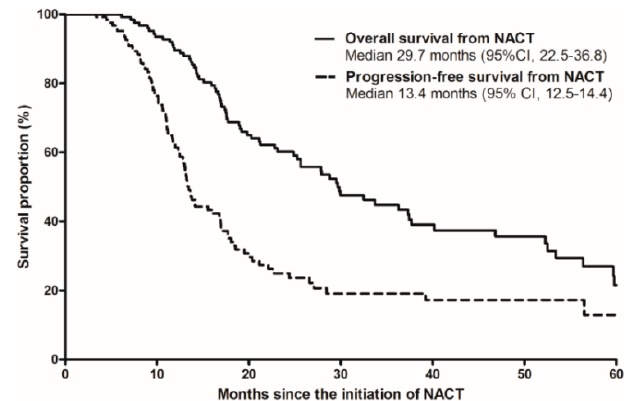
Figure 2. Overall survival (solid line) and progression-free survival (dotted line) from the initiation of neoadjuvant chemotherapy surgery in patients with conversion surgery after neoadjuvant chemotherapy (NACT).